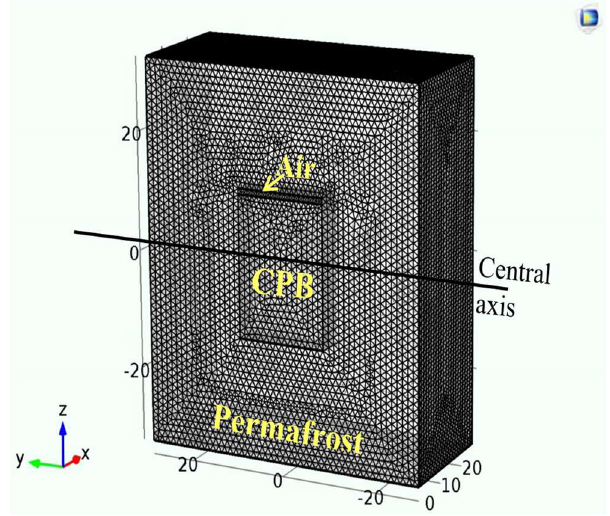
Figure 8. 3D geometry and meshing for the mine stope model.